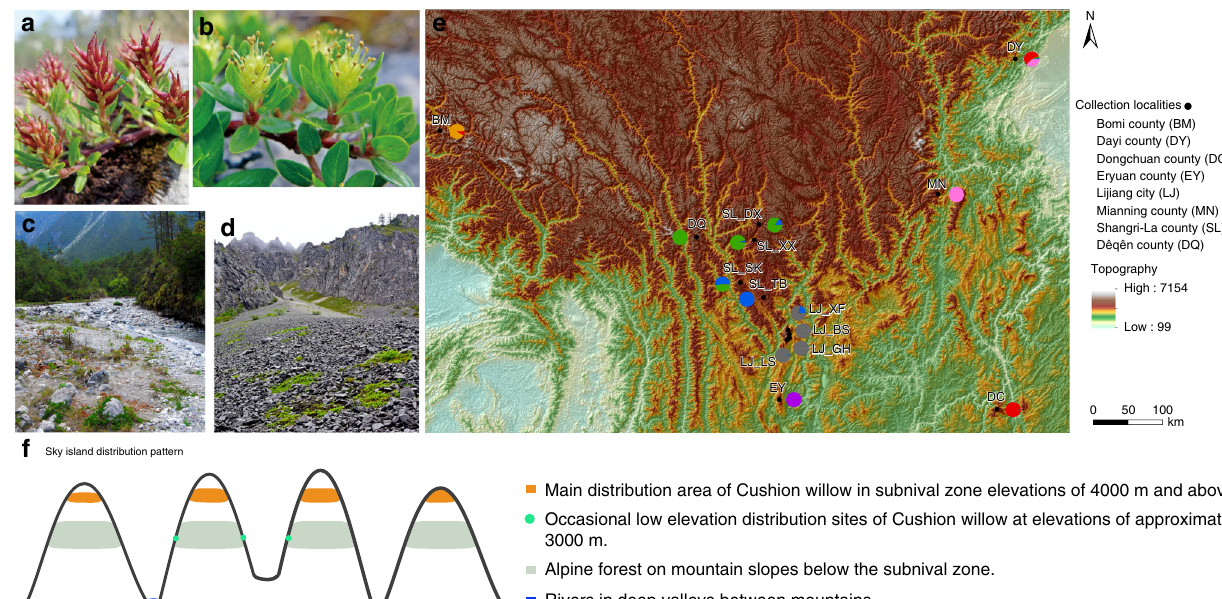
Fig. 1 Cushion willow distribution pattern and locations of population samples. a Female individual with fl owers. b Male individual with fl owers. c Low elevation Cushion willow population located on open river bank at an elevation of 2950 m above sea level. d High elevation Cushion willow population on a scree slope at an elevation of 4000 m. e Sample locations of the 14 Cushion willow populations in HDM and nearby area of the eastern Himalaya. Pie charts at sampling locations indicate the distribution of genetic groups identi fi ed by a Structure analysis of the population. f Scheme of sky island distribution